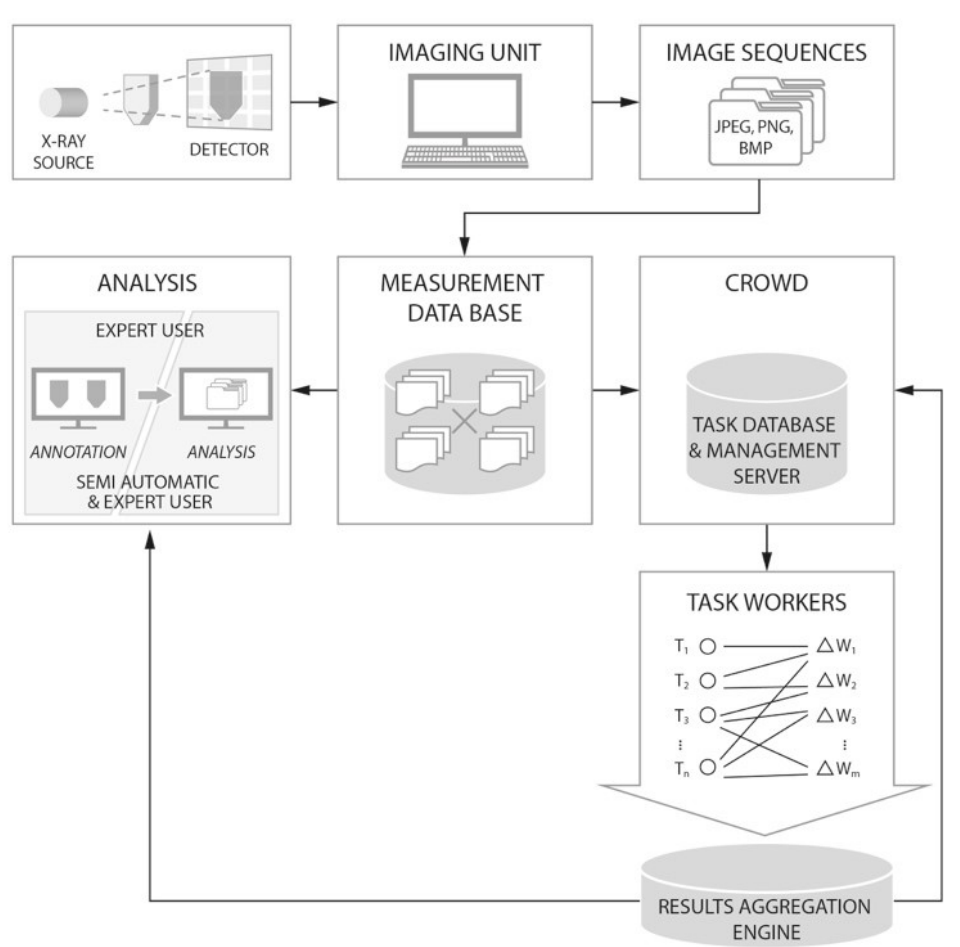
Figure 5. Complete workflow diagram of the data processing and analysis system for tracking particles during bulk solid flow monitored by X-ray